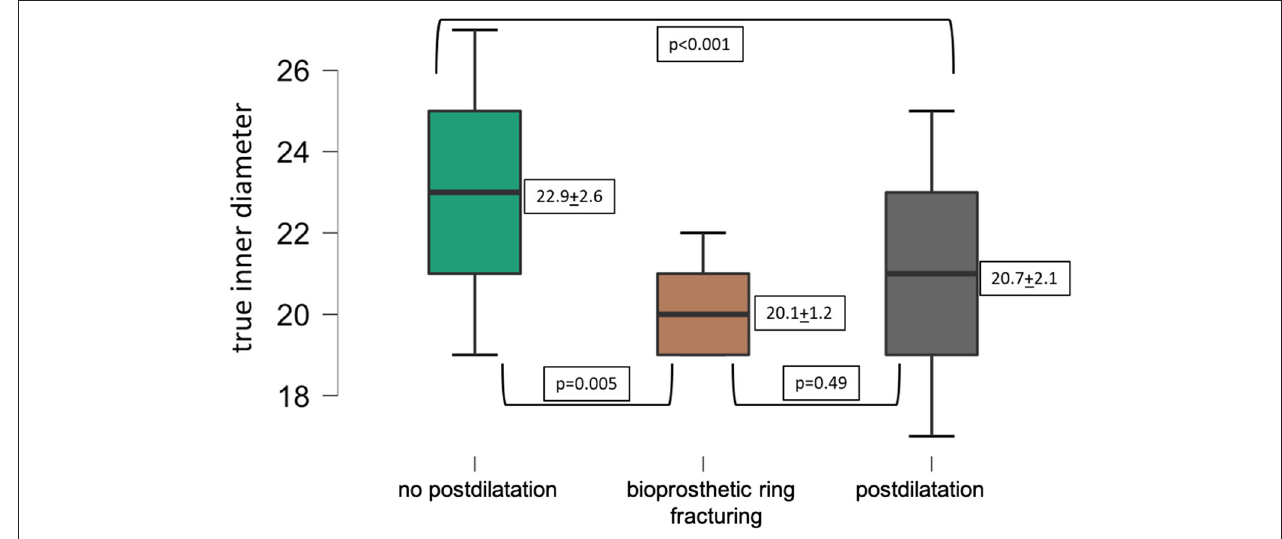
FIGURE 1 | Mean true inner diameter of failing surgical valves.